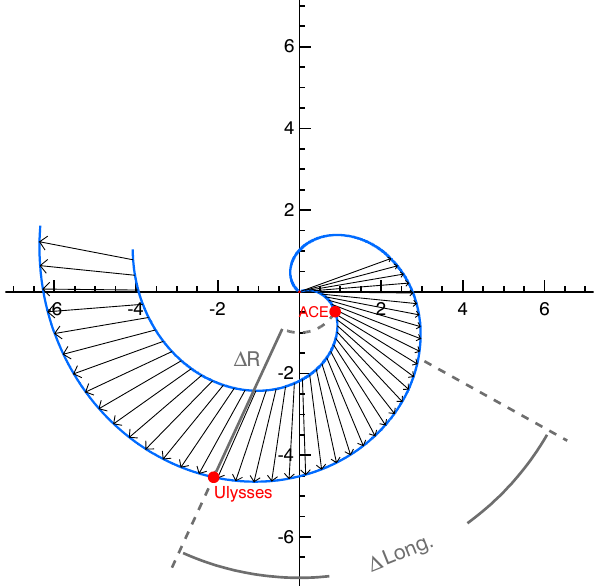
Fig. 3. Density and temperature data divided into radial bins and averaged. Simulation results are shown in grey, ACE and Ulysses data are shown in black. Description of the data set and binning is provided in the